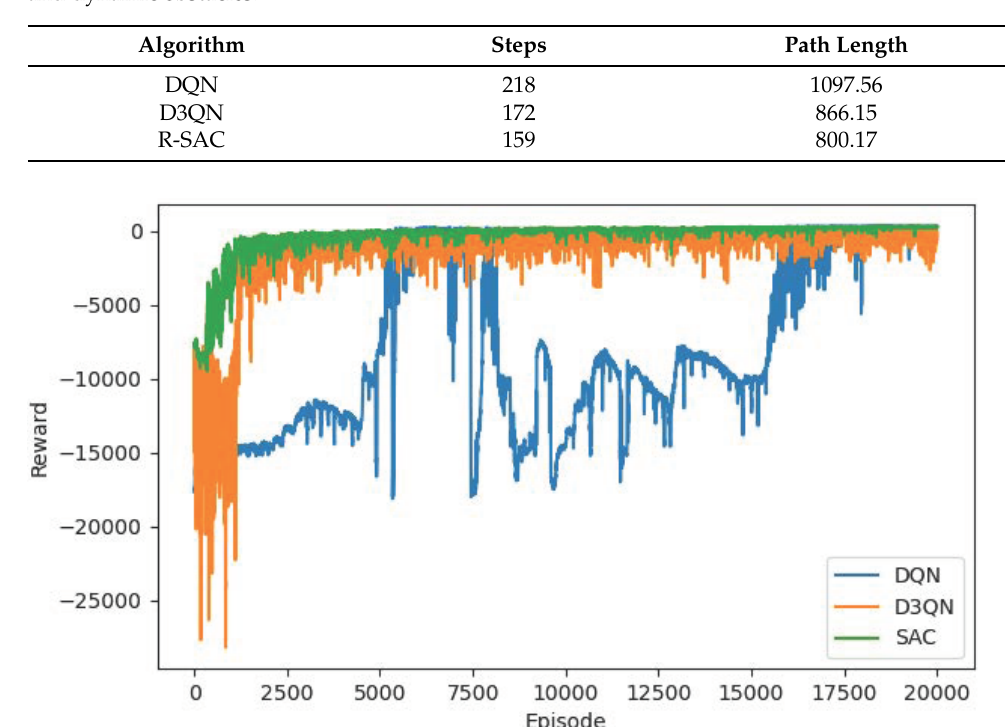
Table 6. The steps and path length of DQN, D3QN, R-SAC algorithm with target point of (500, 500) and dynamic obstacles.